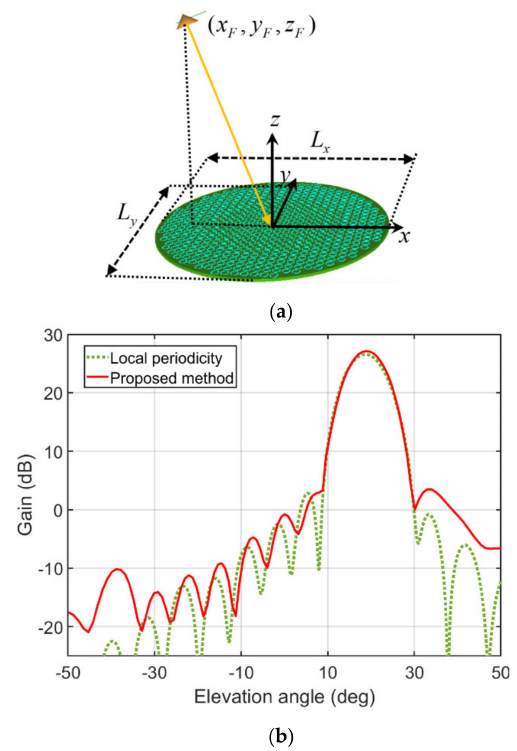
Figure 9. ( a ) Circular polarized focused beam reflectarray of rotated split rings. ( b ) Radiation patterns in elevation plane for right handed circular polarization at 12 GHz. Numerical results obtained